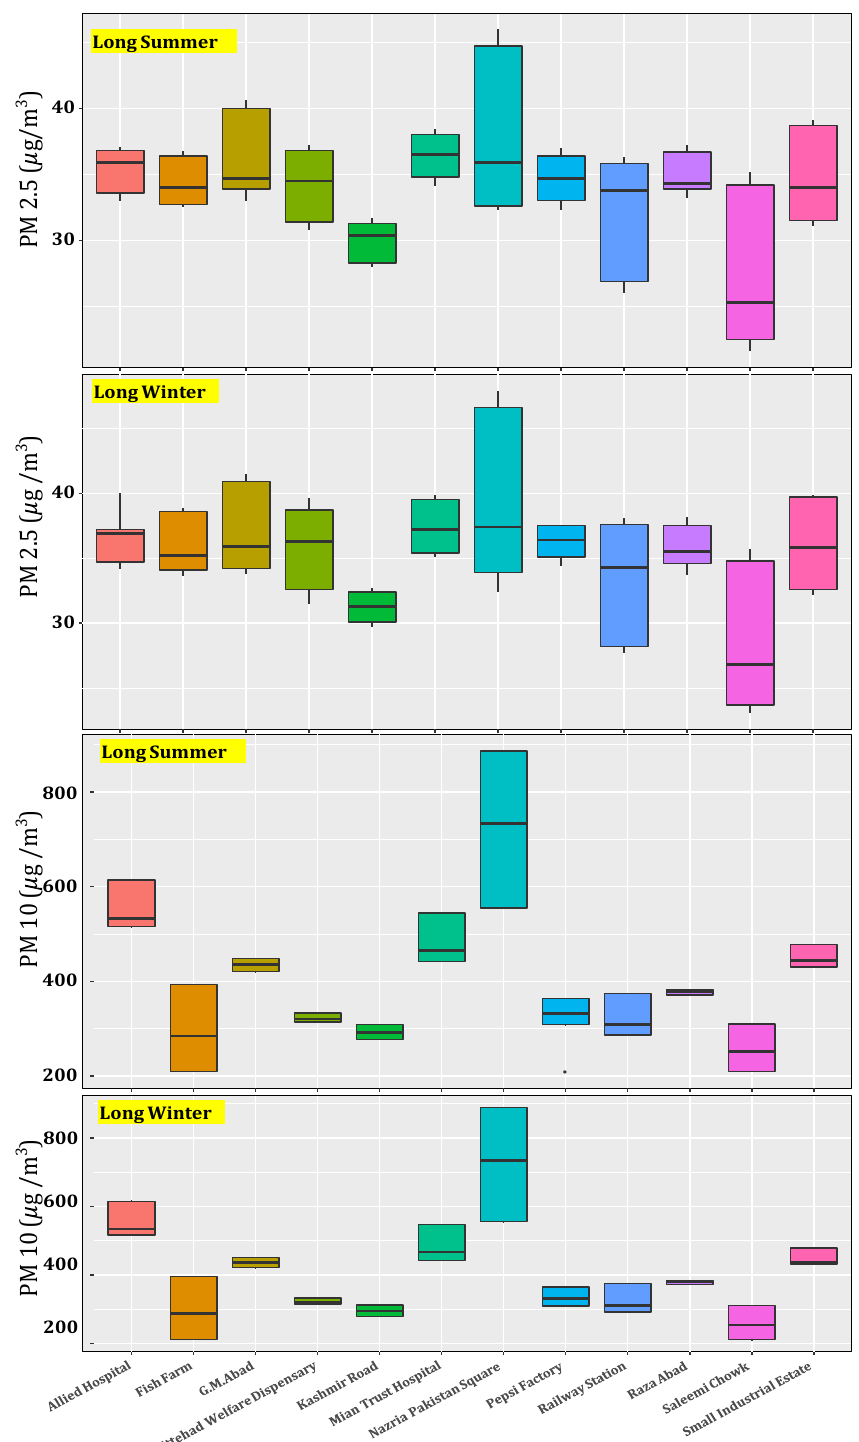
Figure 2. Average mass concentrations of PM 2.5 and PM 10 in long summer and long winter in Faisalabad city.